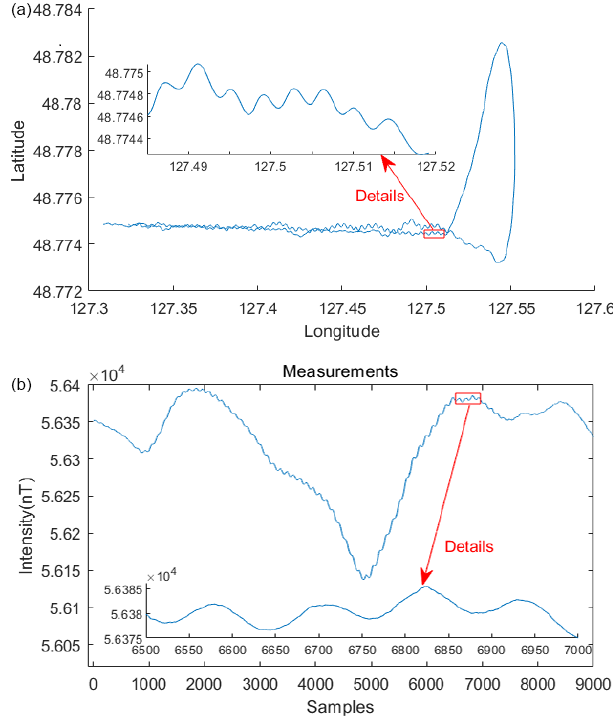
Figure 2. Straight line and